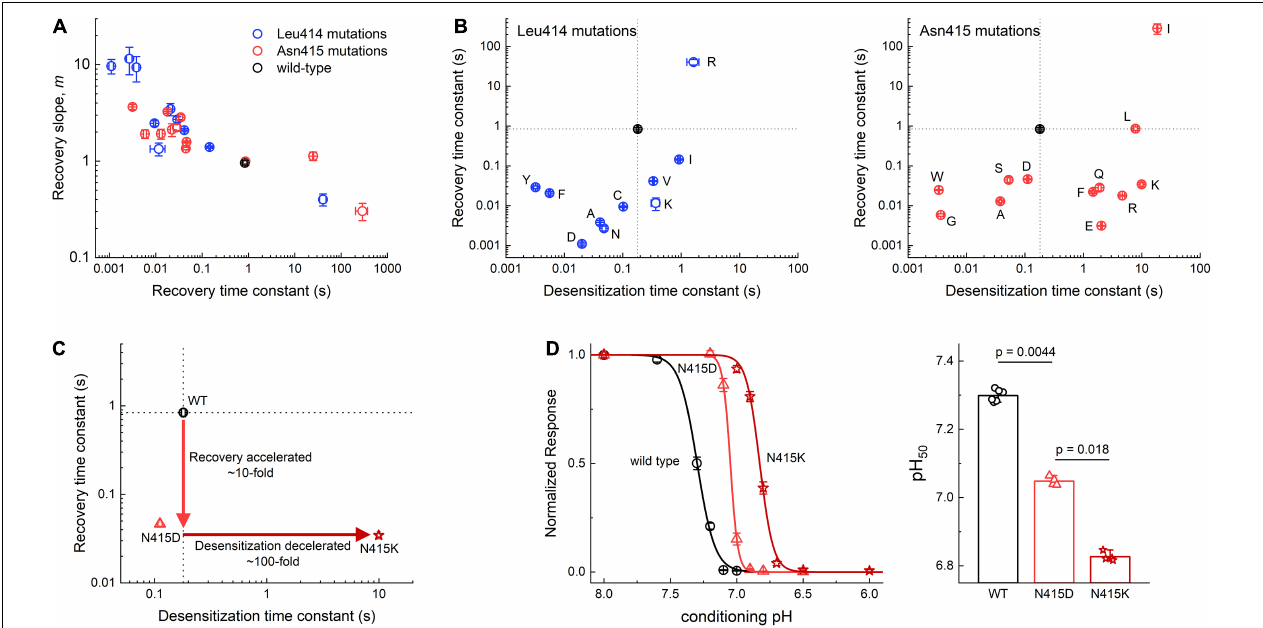
FIGURE 3 | Summary of Leu414 and Asn415 mutant kinetics. (A) Recovery slope ( m ) vs. time constant ( τ ) of the recovery curve for mutant series in Leu414 (blue) or Asn415 (red). (B) Summary of entry and exit time constants for each mutant in L414 (left) and Asn415 (right). Note that the wild type side chains (black) are relative isolated with any deviation producing order of magnitude changes in kinetics. (C) N415D has ∼ 10 fold faster recovery with comparable desensitization vs. wild type. N415K has ∼ 100 fold slower desensitization with comparable recovery as N415D. (D) Steady-state desensitization curves for wild type, N415D and N415K (left) and pH 50 s from each patch. P -values are from randomization tests. All error bars are SEM.